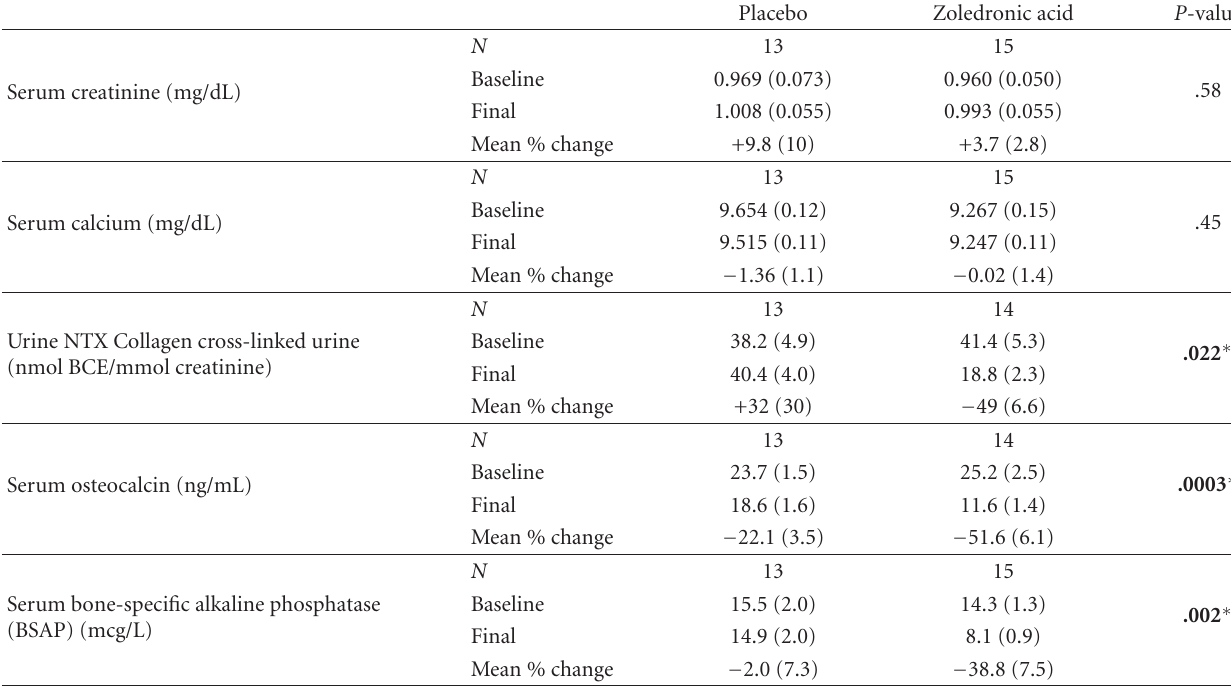
Table 2: Comparison of mean and SE percent change in biochemical markers of bone turnover from baseline to final between the two groups. Significant di ff erences were observed in urine NTX, osteocalcin, and BSAP. Placebo Zoledronic acid P -value